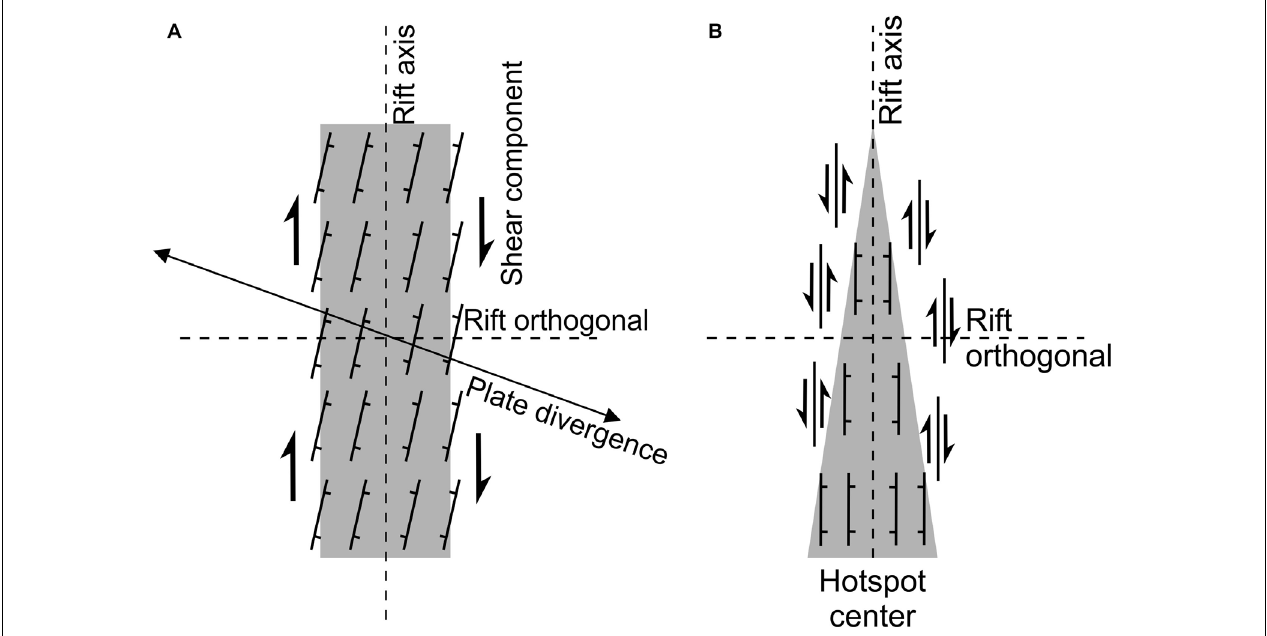
FIGURE 1 | Sketches of rift zones with rift-parallel shear component that takes place through different fault patterns: (A) oblique rifting with en-échelon faults, the strike of which is not perpendicular to plate separation direction (modified after Fournier and Petit, 2007). (B) Partitioning of motions with strike-slip faults at the sides of a rift that is propagating outward from a hotspot center (modified after Karson, 2017).